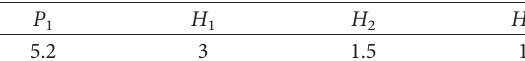
Table 1: Optimum dimensions of the antenna element (unit: mm).